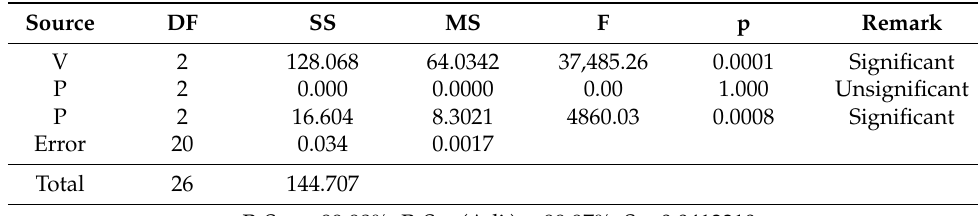
Table 13. ANOVA results for cutting efficiency.